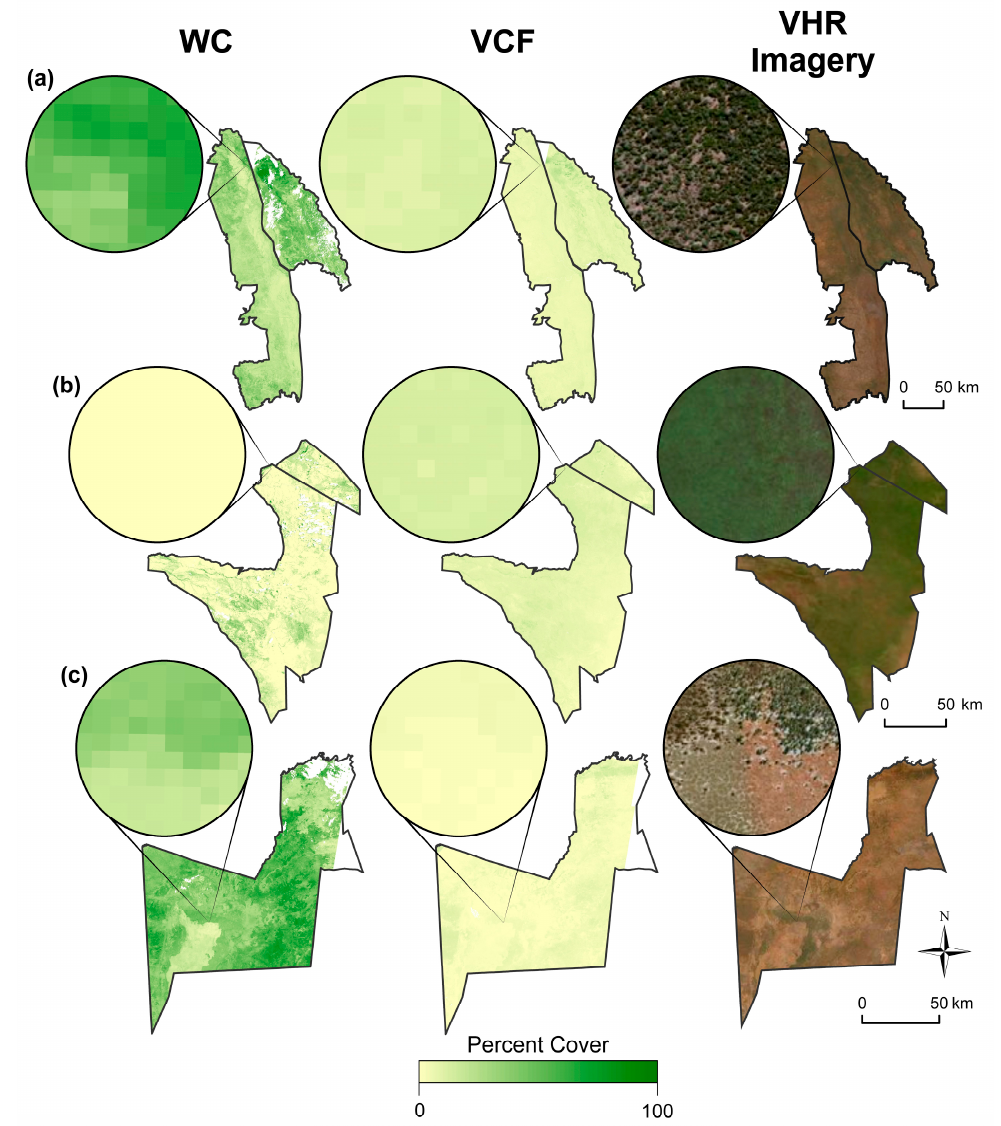
Figure 7. A comparison of the best WC maps (“Best Overall Model” in Table 4) and VCF with VHR satellite imagery for reference. All inset maps have diameters of 275 m. Our maps for KRU and LIM ( a ), SMR ( b ) and CHO ( c ) capture gradients in WC (KRU / LIM inset), the complete absence of WC (SMR inset) and ecotones (CHO inset) better than VCF. CHO and LIM both show data missing at their eastern and western boundaries, respectively, from excluded Landsat paths that did not cover > 10% of the PA. LIM, SMR, and CHO also all show some areas where cloud masks removed data. Our maps and VCF have a resolution of 30m. The VHR imagery has a resolution < 1m. This figure was produced using Esri ArcGIS. Satellite imagery from ArcGIS base map. Source: Esri, DigitalGlobe, GeoEye, Earthstar Geographics, CNES / Airbus DS, USDA, USGS, AEX, Getmapping, Aerogrid,